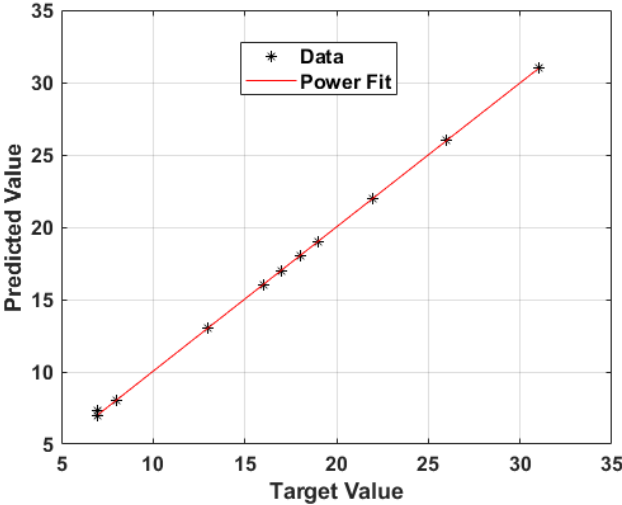
Figure 17. System failure plot of target vs. predicted value for ANN Model 2 training.